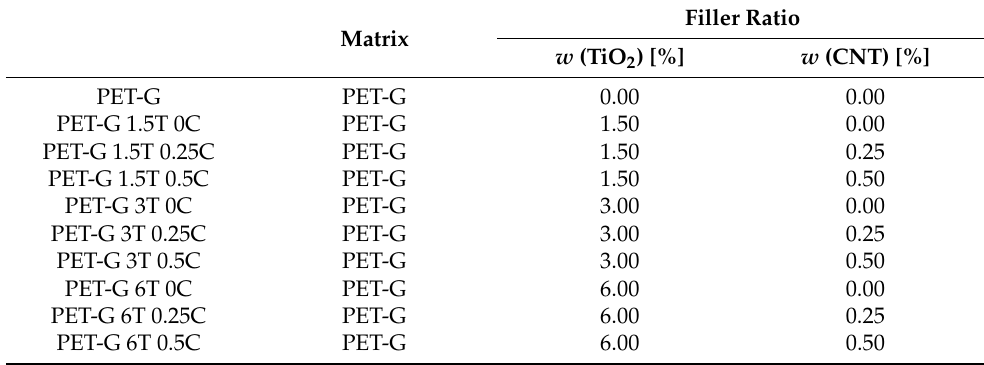
Table 1. Mass ratios of added fillers for all samples.